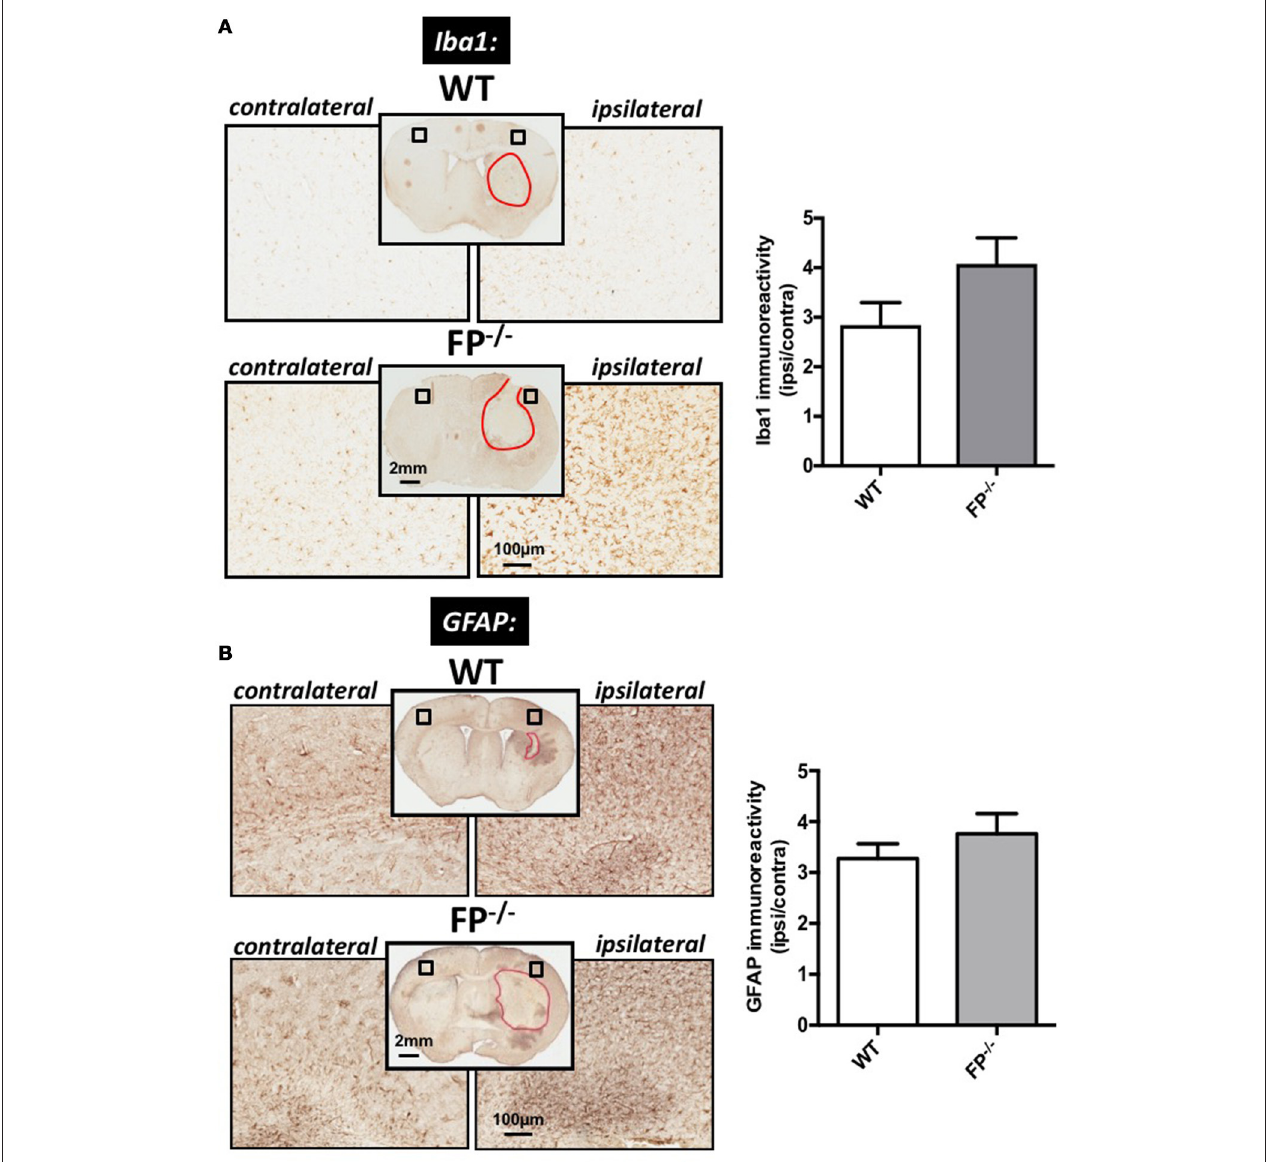
FIGURE 3 | Effect of PGF 2 α -FP receptor deletion on microgliosis and astrogliosis post-ICH. At 72h after ICH, WT, and FP − / − mice were euthanized and brains processed for Iba1 and GFAP immunohistochemistry in order to evaluate cortical gliosis. (A) Representative high magnification images of coronal brain sections show the ipsilateral and contralateral cortex for WT (upper panels) and FP − / − mice (lower panels). Square selections in the inserts denote magnified regions. Quantification of brown positive pixel count demonstrated that FP − / − mice had a trend toward greater cortical Iba1 immunoreactivity then WT mice (WT: n = 10, FP − / − : n = 12). This trend in microglial activation was accompanied by morphological changes. (B) Quantification of brown positive pixel count demonstrated that FP − / − mice had relatively the same level of cortical GFAP immunoreactivity as WT mice (WT: n = 7, FP − / − : n = 8). All data was normalized to the corresponding contralateral equivalent areas. Iba1 = Ionized calcium-binding adapter protein; GFAP = glial fibrillary acidic